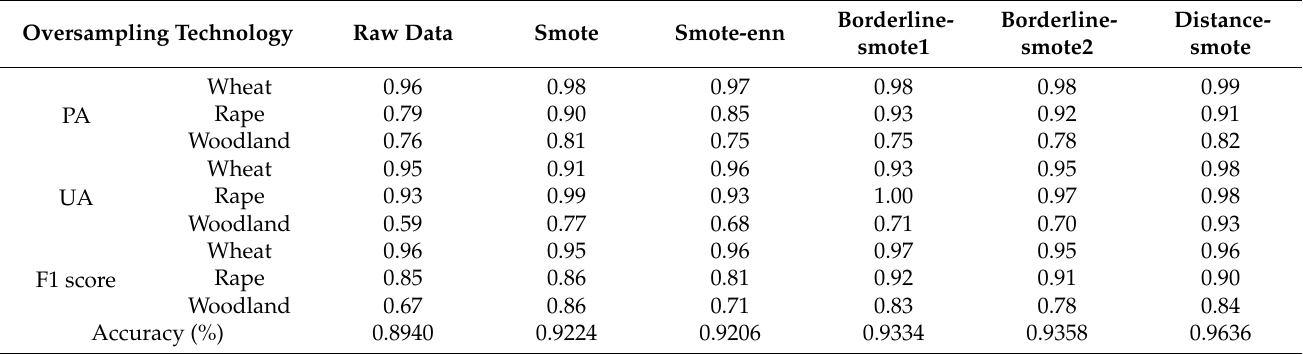
Table 5. Classification accuracy of different oversampling algorithms.